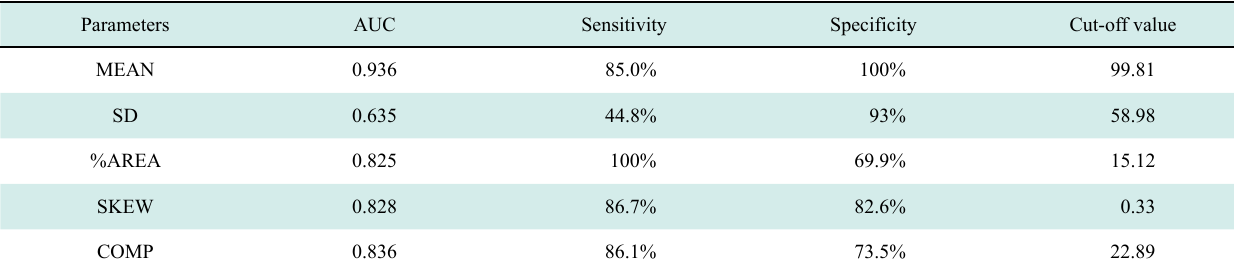
Table 6 ROC curves of elastography results and parameters